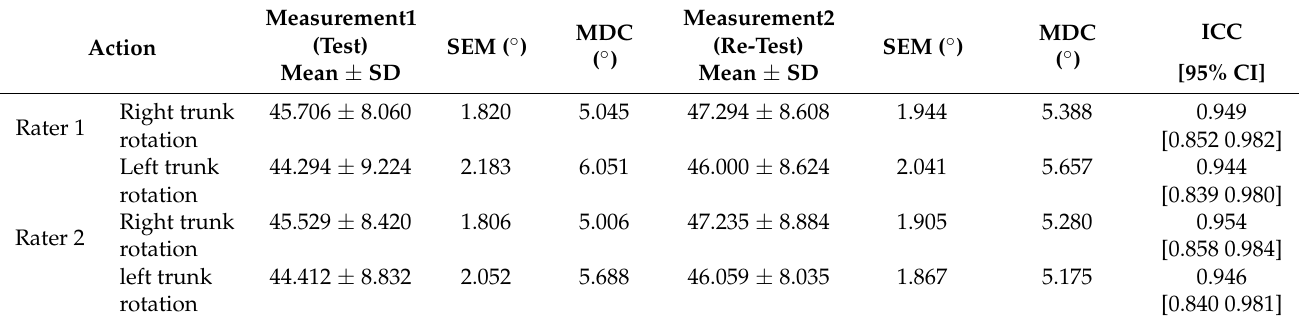
Table 2. Intra-rater reliability of the two measurements performed by